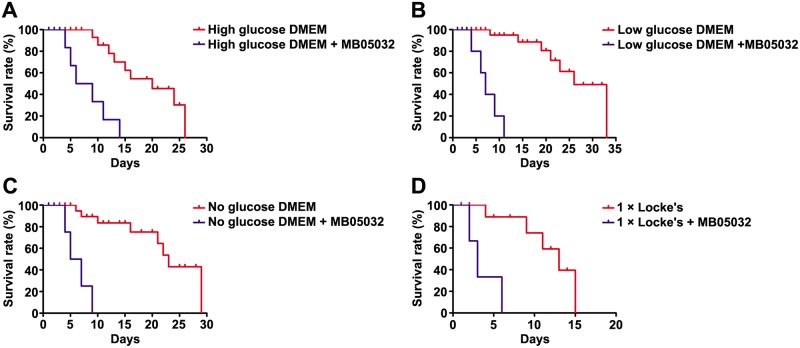
Survival curve of C. sinensis adults with or without MB05032 treatment.Adult flukes were respectively maintained on high, low, and no glucose DMEM (A, B, and C), as well as 1 × Locke’s (D) with or without the addition of MB05032. Survival curve of adult flukes was constructed using Kaplan-Meier analysis with the log-rank test.